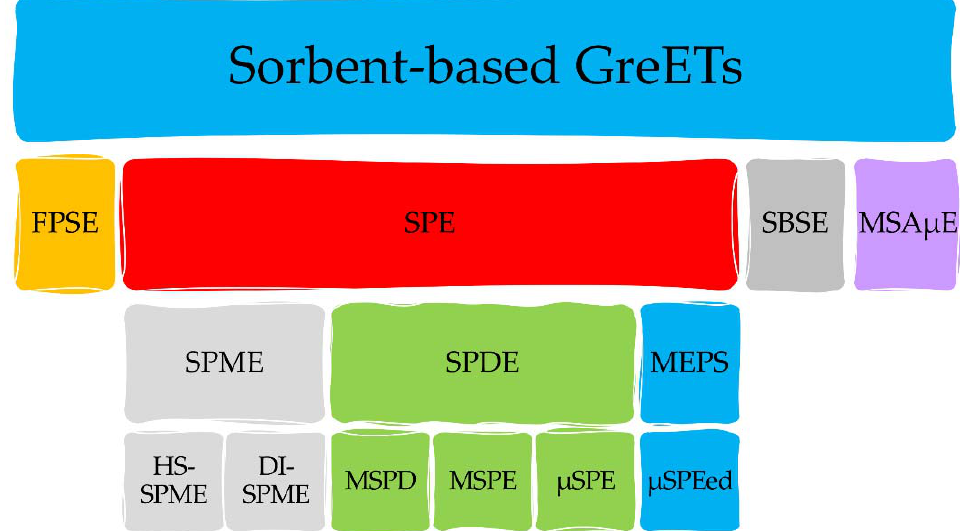
Figure 2. Different sorbent-based GreETs used in several fields of analysis. Legend: DI-SPME: solid-phase microextraction in direct immersion mode; FPSE: fabric-phase solvent extraction; GreETs: green extraction techniques; HS-SPME: solid-phase microextraction in headspace mode; MEPS: microextraction in packed sorbent; MSA µ E: multisphere adsorptive microextraction; MSPD: matrix solid-phase dispersion; MSPE: magnetic solid-phase extraction; SBSE: stir-bar sorbent extraction; SPDE: solid-phase dynamic extraction; SPE: solid-phase extraction; SPME: solid-phase microextraction; µ SPE: micro-solid-phase extraction.